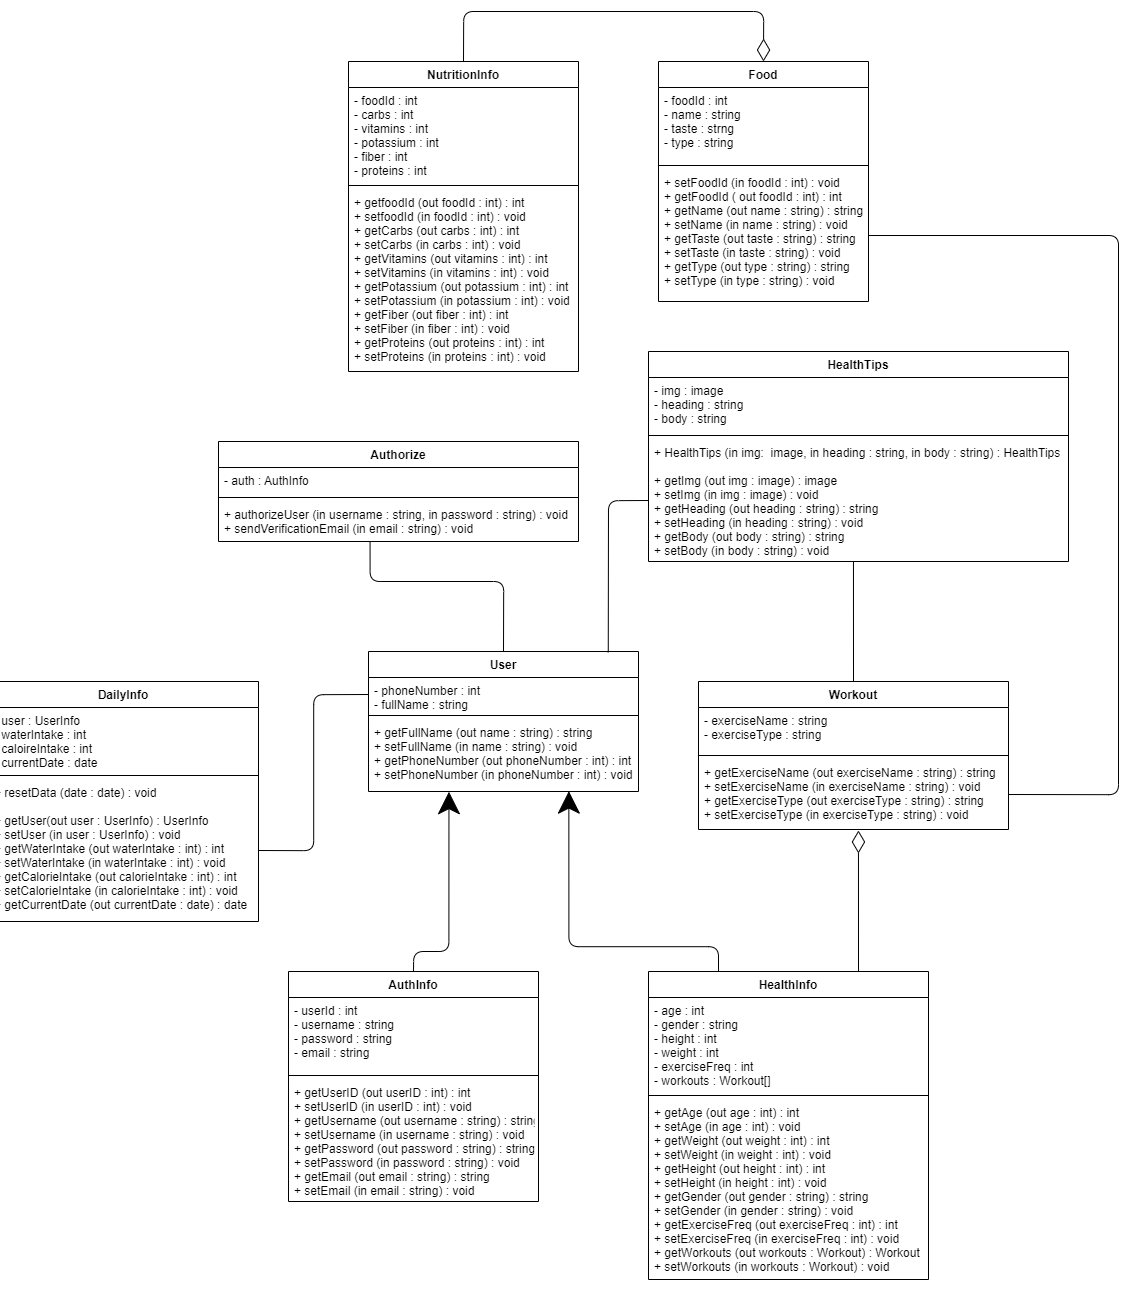
Figure 13. Class Diagram of the Proposed